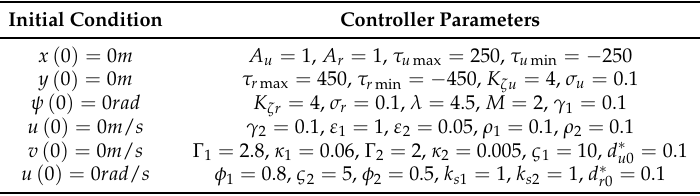
Table 2. Initial conditions and controller